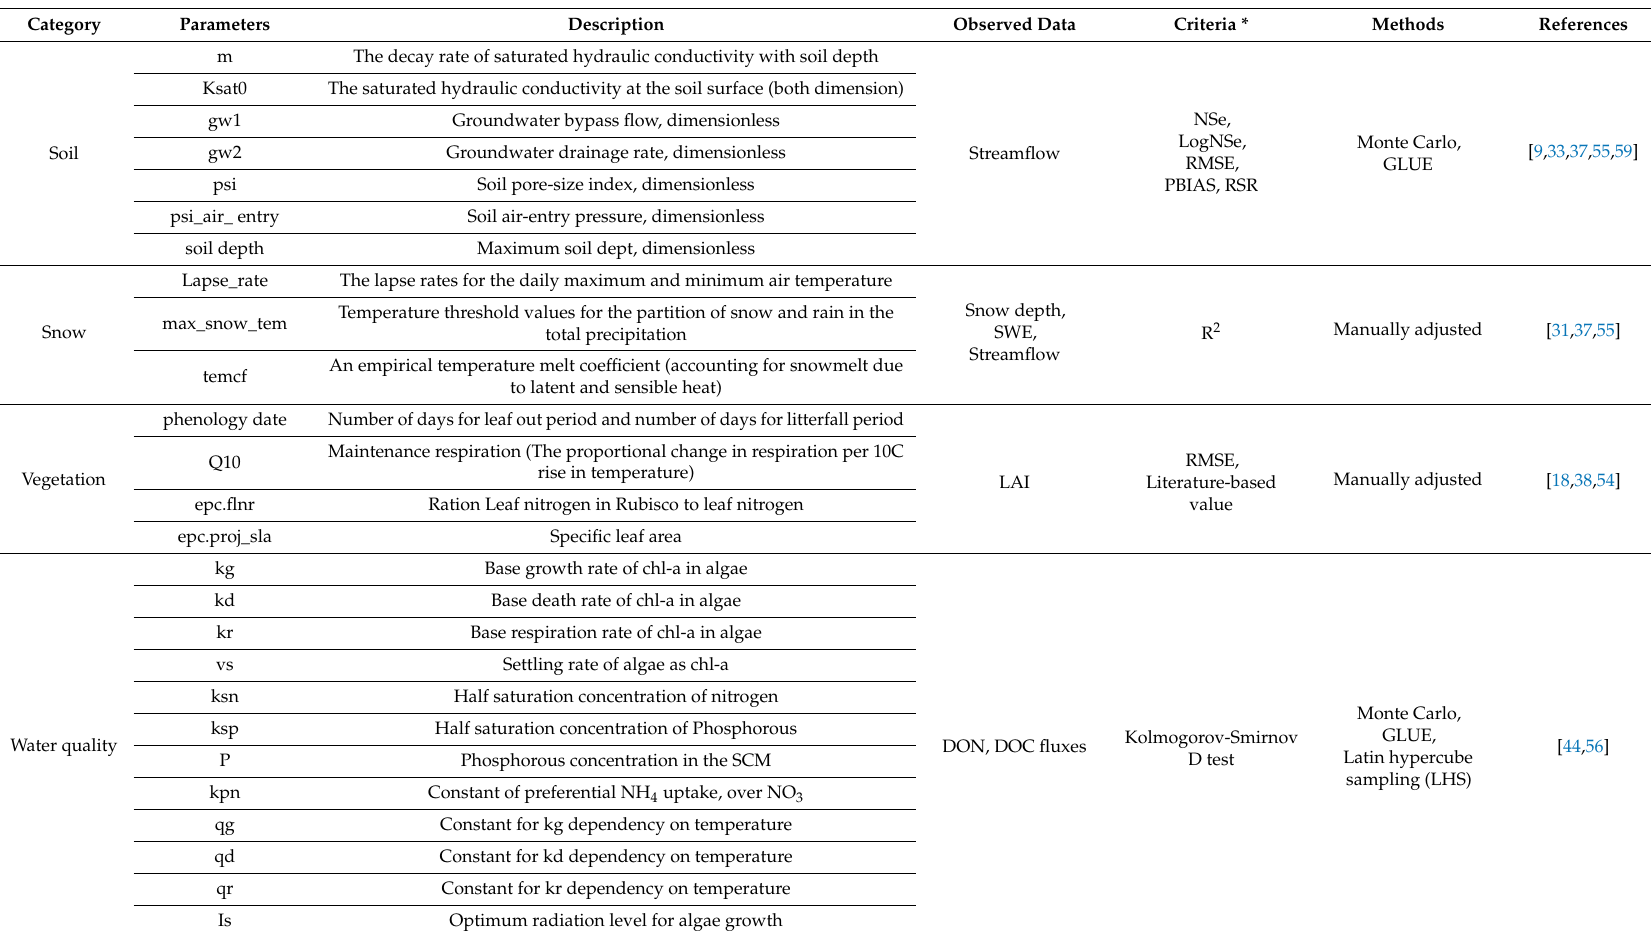
Table 2. The details for calibrating RHESSys in existing